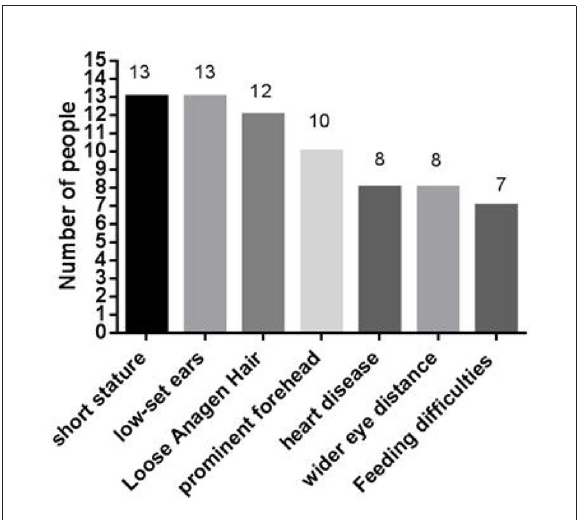
FIGURE6 The type of NSLH2 clinical manifestations in 17 cases caused by PPP1CB gene